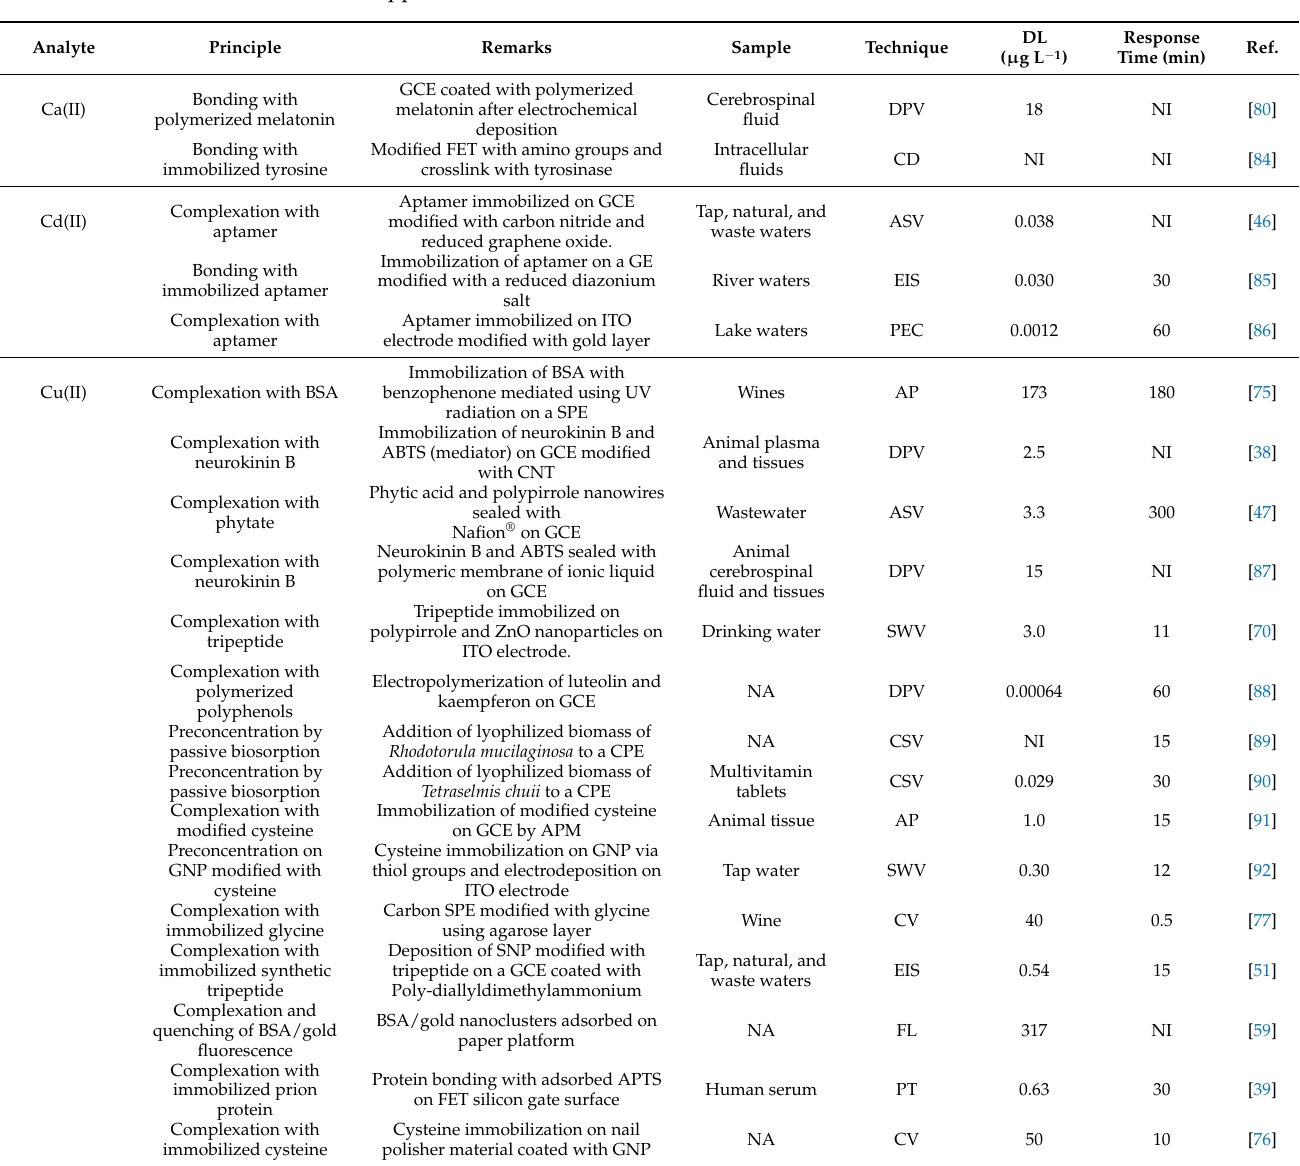
Table 1. Selected applications based on an accumulation of ions on the biosensor surface.